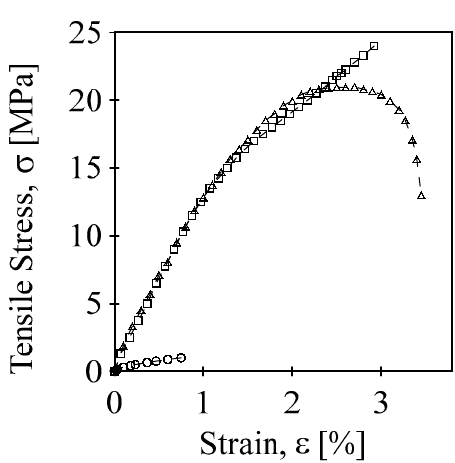
Figure 4. Tensile tests on the MWCNT nanopaper (circles), the MWCNT nanopaper/epoxy composite (squares), and the cured epoxy (triangles) at elongation rate of 5 mm/min.